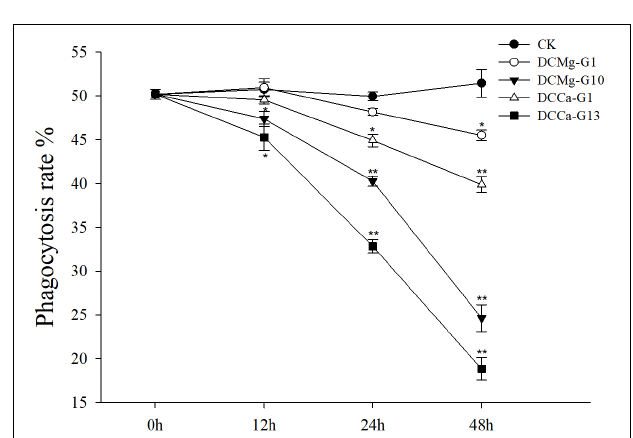
carbonate shell loss when Ca 2 + was less than 0.19 mmol · L − 1